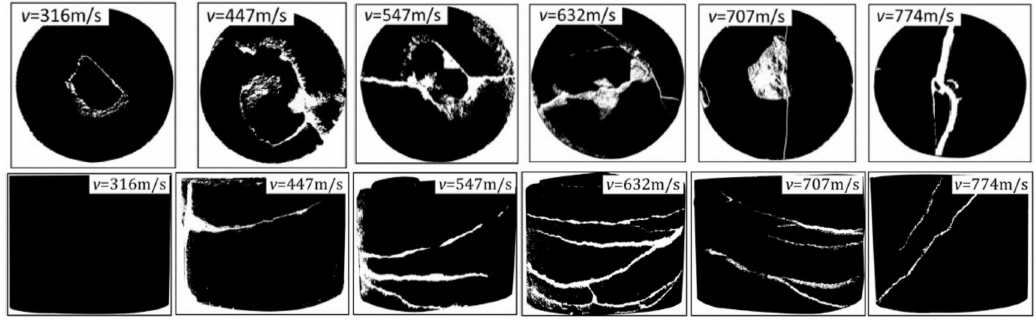
Figure 6. High-resolution images of coal-rock specimens showing the effect of the